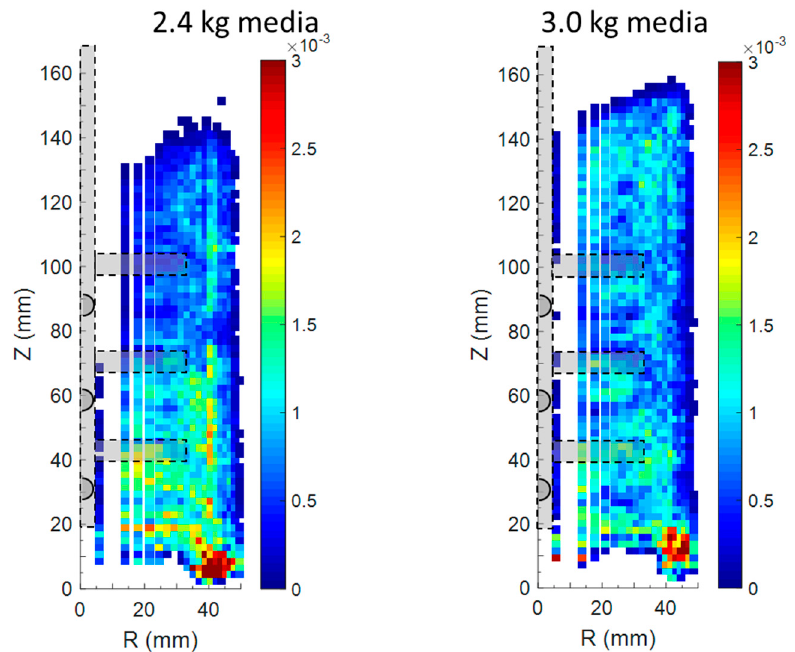
Figure 12. PEPT normalised tracer occupancy plot for two bead loading: 2.4 kg and 3.0 kg of media. Test case using the clearance of 19 mm and the impeller speed of 600 rpm.